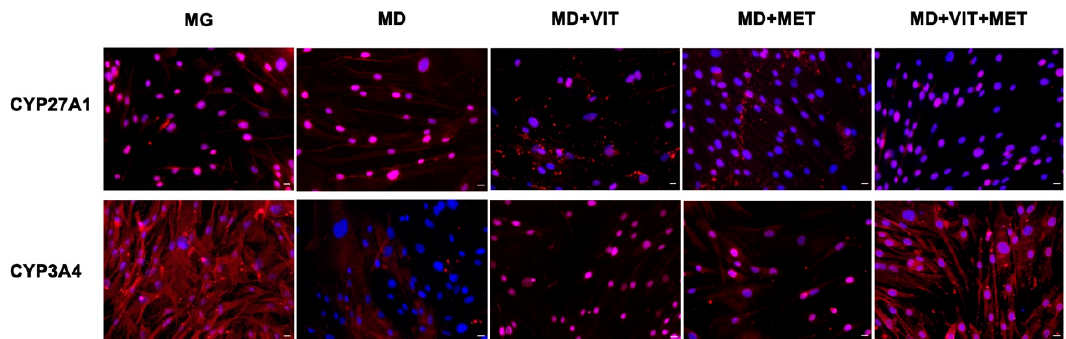
Figure 6. Analysis of CYP450 after 21 days in culture. Immunohistochemical analysis of the expression of CYP27A1 and CYP3A4 was assessed in ADSCs cultured in the basic growing medium (MG) or and in the differentiation medium (MD) or the differentiation medium plus vitamin D (MD+VIT) or metformin (MD+MET) or with both vitamin D and metformin (MD+VIT+MET). The figures are representative of different independent experiments. Nuclei are labelled with 4,6-diamidino-2-phenylindole (DAPI, blue). Scale bars: 40 µm.